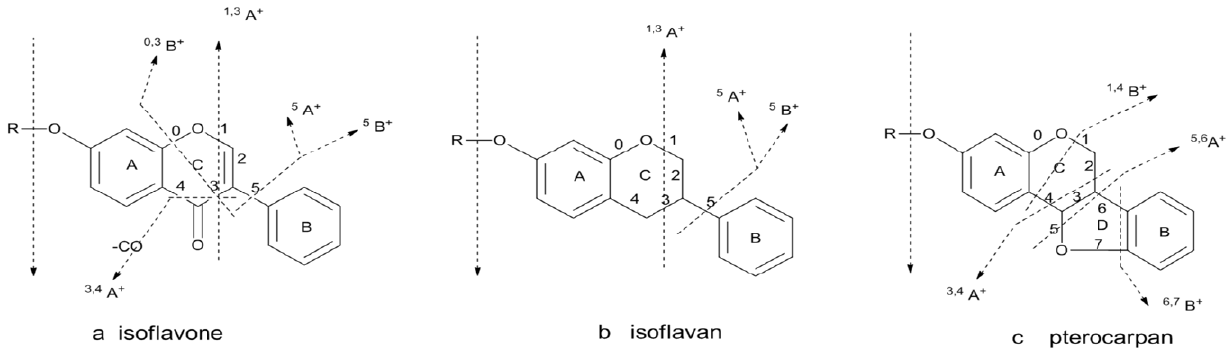
Figure 2. The bond cleavage pathways of the three types of isoflavonoids in